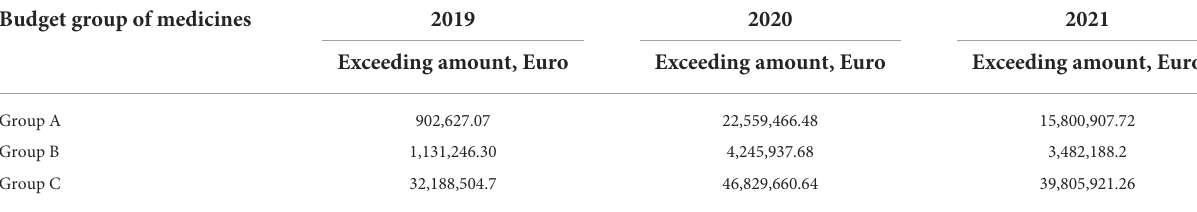
TABLE 3 Paid-back expenditure by Marketing Authorisation Holder (MAH).